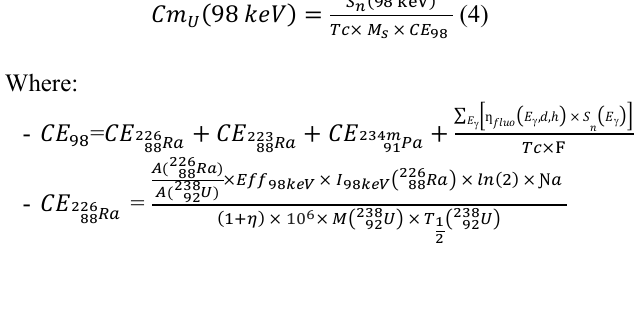
Fig. 2. Gamma spectrum and induced fluorescence X-rays for a 200 keV mono-energy photon source. The fluorescence yield and the three radioactive decay emissions listed above allow us to convert the net area of the 98 keV peak into a uranium mass concentration using equation (4). It is important to notice that, in order to limit the number of simulations, only the six more intense gamma rays were taken into account to calculate the fluorescence yield: 185 keV ( 214 Pb), 242 keV ( 214 Pb), 298 keV ( 214 Pb), 352 keV ( 214 Pb), 609 keV ( 214 Bi) and 1120 keV ( 214 Bi). As they represent 78 % of the total fluorescence signal, a correction factor F equal to 0.78 is used in equation